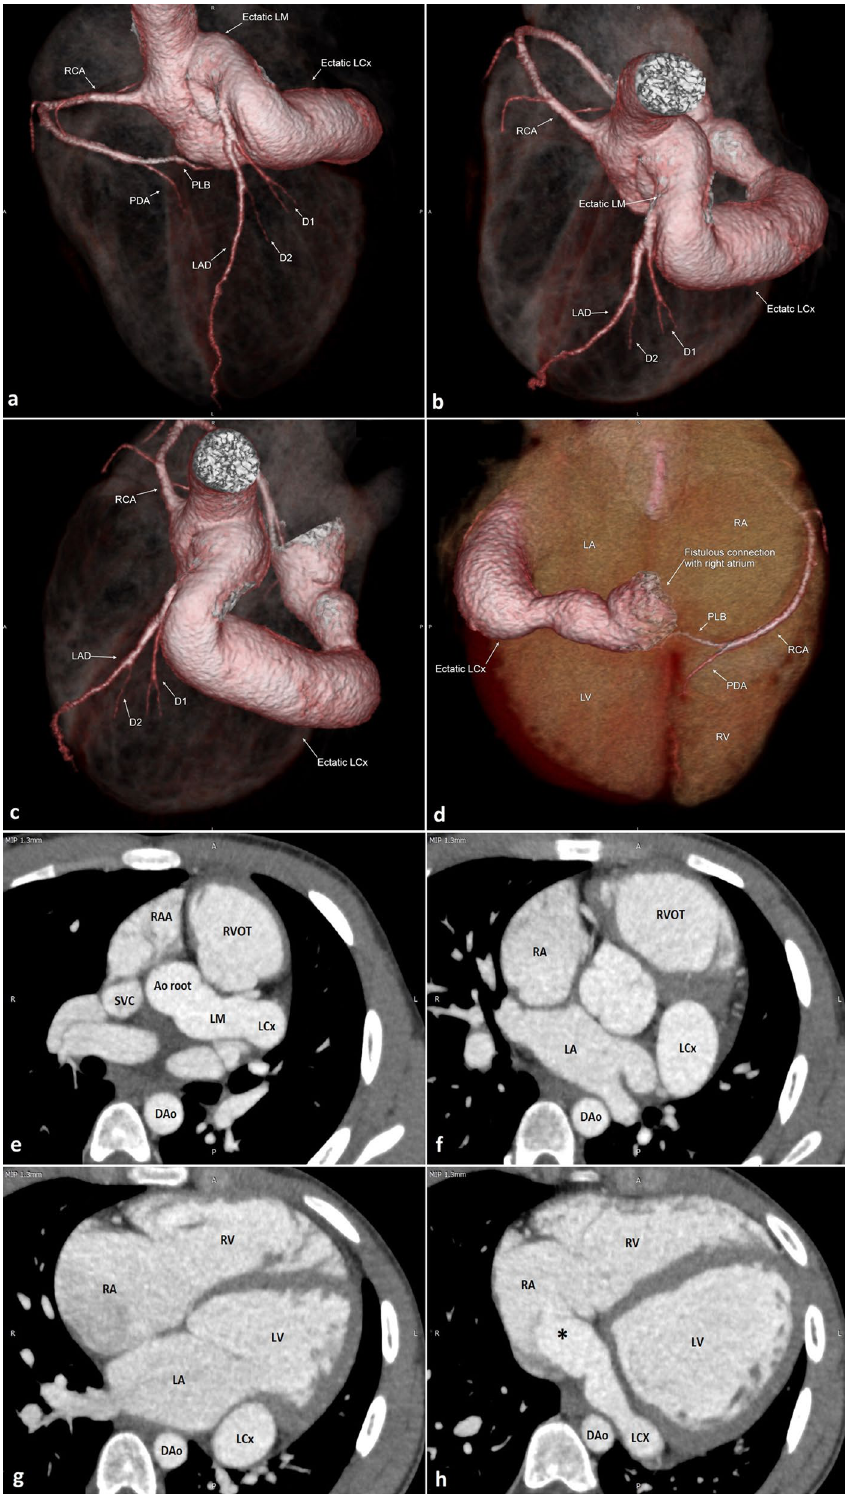
Fig. 3 Large distal LCx coronary artery fistula with right atrium in 22-year-old male patient with dyspnea. Semitransparent 3D volume rendered image ( a–d ) showing markedly ectatic left main coronary artery and LCx due to abnormal large fistulous connection between distal LCx and right atrium. Axial thin MIP images showing markedly ectatic left main coronary artery as well as LCx ( e , f ), the latter runs within left atrioventricular groove ( g ) and finally shows large fistulous connection with right atrium (asterisk in h ). There is biventricular dilatation as